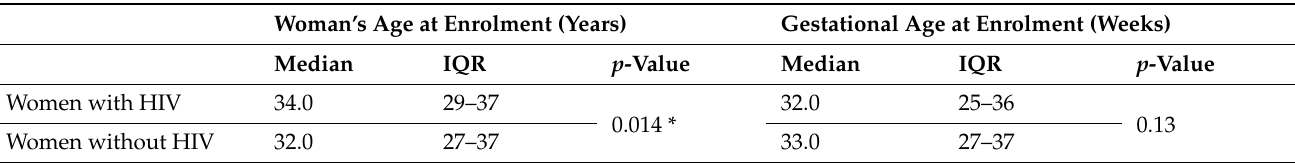
Table 1. Comparison of age and pregnancy stage at enrollment based on HIV status .